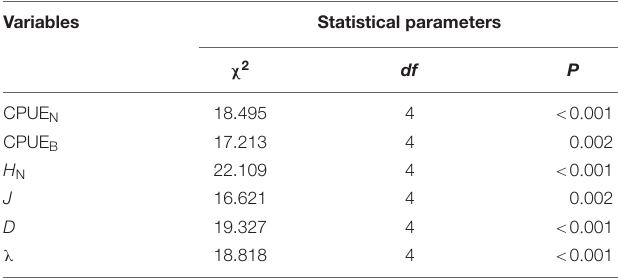
TABLE 4 | Detailed information on results from the non-parametric, one-way ANOVA (i.e., Kruskal–Wallis test) models evaluating potential differences in the mean catch per unit effort of fishes [in both numerical (CPUE N ) and biomass (CPUE B ) terms] and the fish community diversity metrics ( H N , J , D , λ ) among habitat zones.